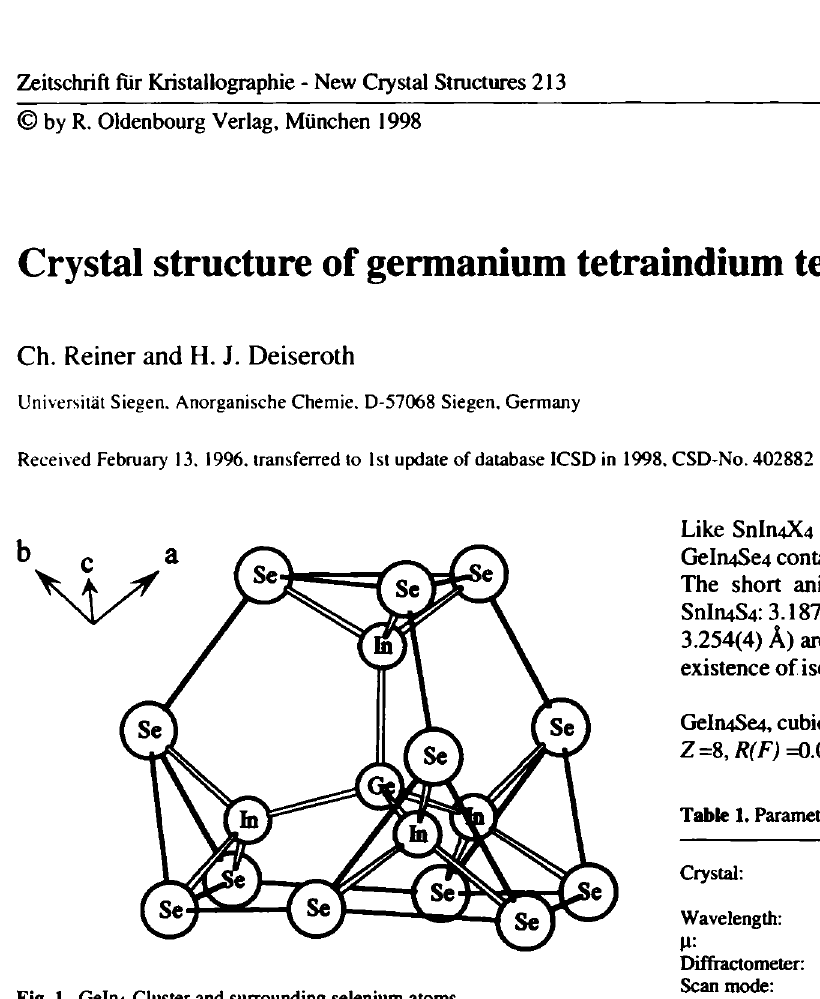
Fig. 1. Geln4 -Cluster and surrounding selenium atoms.